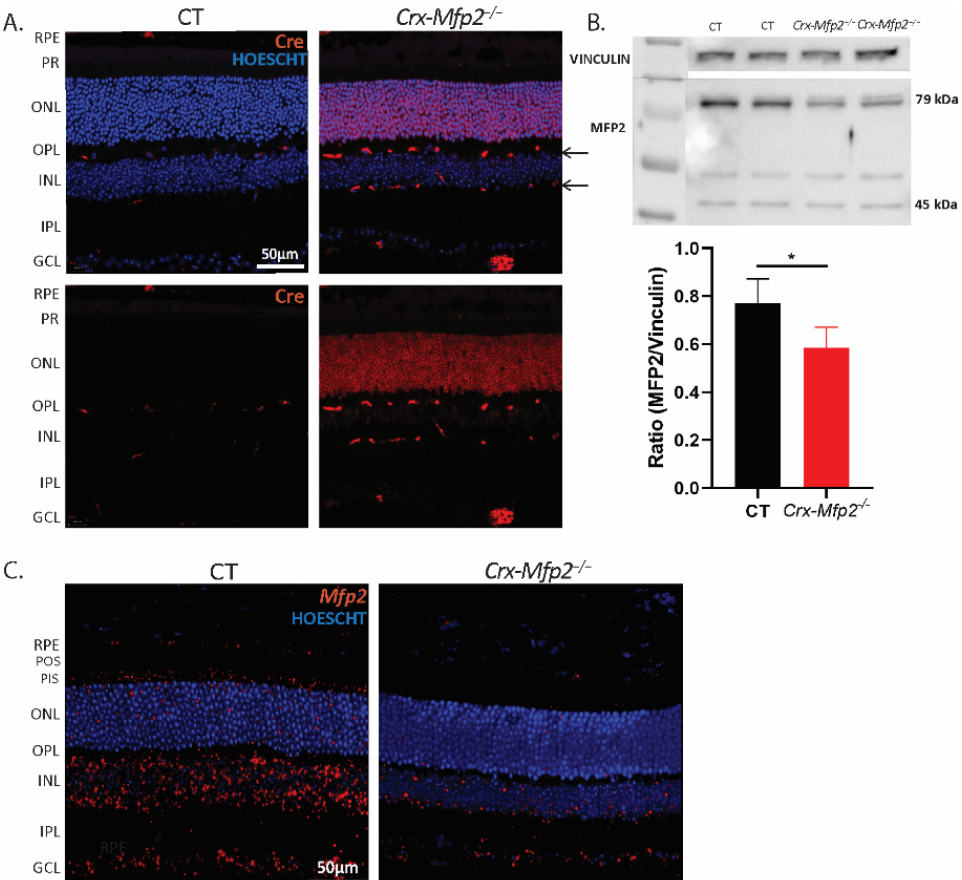
Figure 1. Confirmation of conditional Mfp2 knockout in Crx-Mfp2 − / − mice. ( A ) Immunohistochemical staining for Cre recombinase (red) showed no specific staining in control mice, but clear expression in photoreceptors. Additionally, some expression was seen in the INL in Crx-Mfp2 − / − mice (arrows). ( B ) Western blotting confirmed loss of MFP2 in the neural retina of Crx-Mfp2 − / − mice. The full length MFP2 band and the hydratase band were combined to calculate MFP2 levels. The band around 50 kDa is believed to be aspecific. Vinculin was used as loading control. ( C ) In situ hybridization showed substantial loss of Mfp2 transcripts (red) in the PR, PIS and INL of Crx-Mfp2 − / − mice. N = 4/group. Statistical difference based on unpaired t -test: * p < 0.05. Error bars indicate SD. RPE—retinal